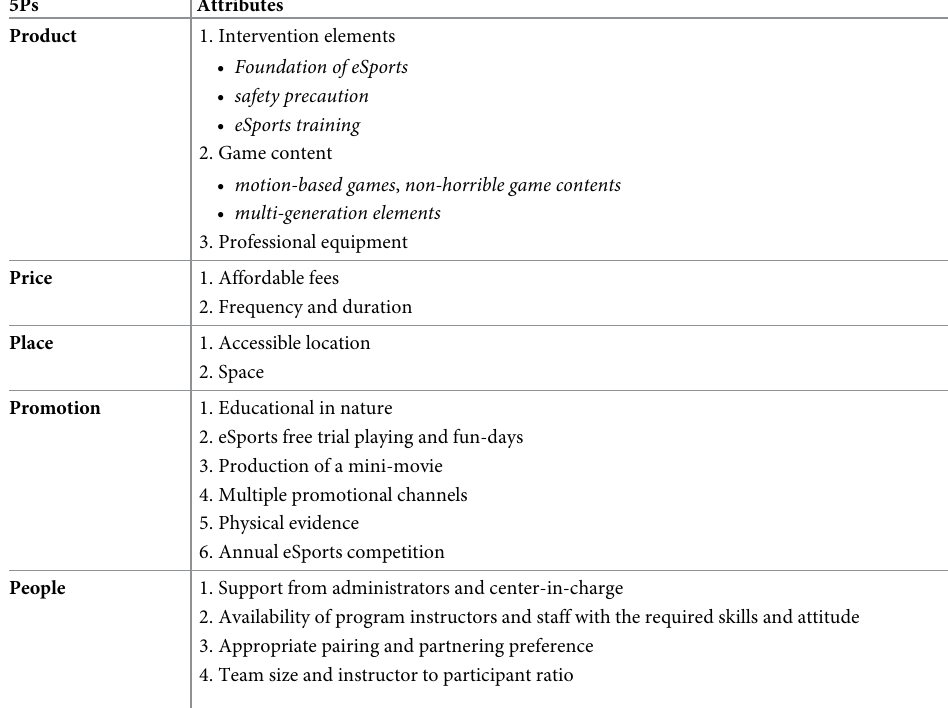
Table 2. Five P’s of the intervention and SM